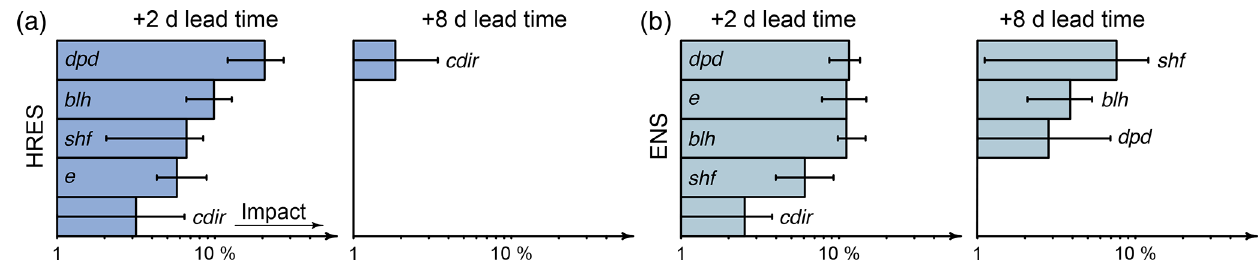
Figure 4. Predictors of Table 2b with the highest impact for medium-range forecasts with + 2 and + 8d lead times. The x axis is logarithmic and shows the percentage decreasing in performance when replacing the true observation of a particular predictor with random information. The error bars show the 25th to 75th percentiles of the decrease in forecast performance for the particular predictors. (a) HRES-based models. (b) ENS-based